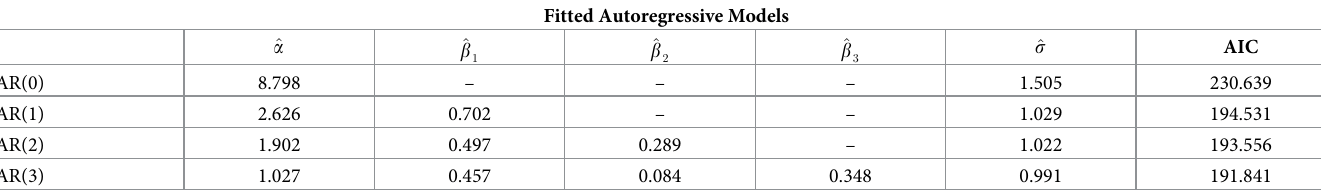
Table 5. Fitted spatial autoregressive models. Fitted spatial AR( p ) models to logarithms of confirmed COVID-19 cases in New York counties.